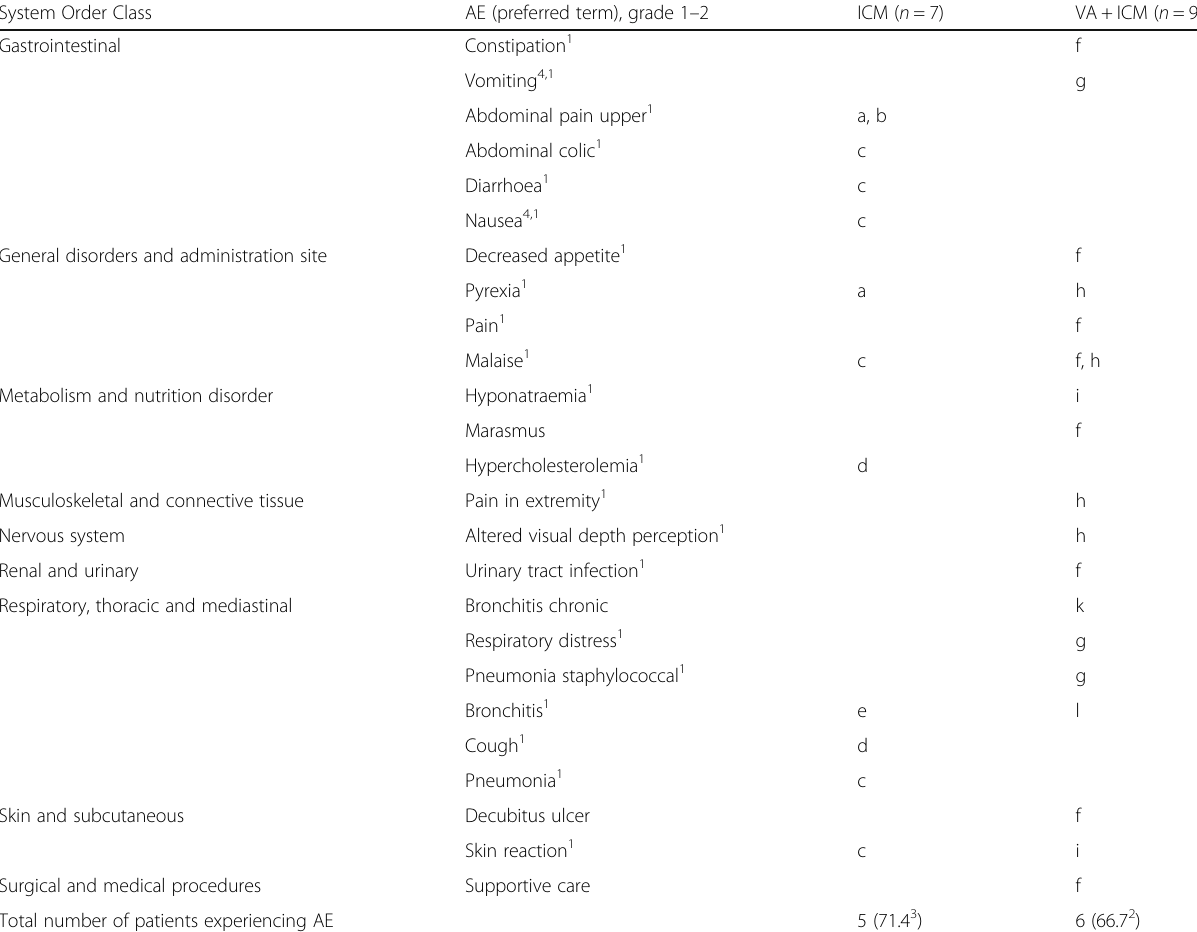
Table 3 Frequency of AEs during treatment with ICM with or without VA therapy System Order